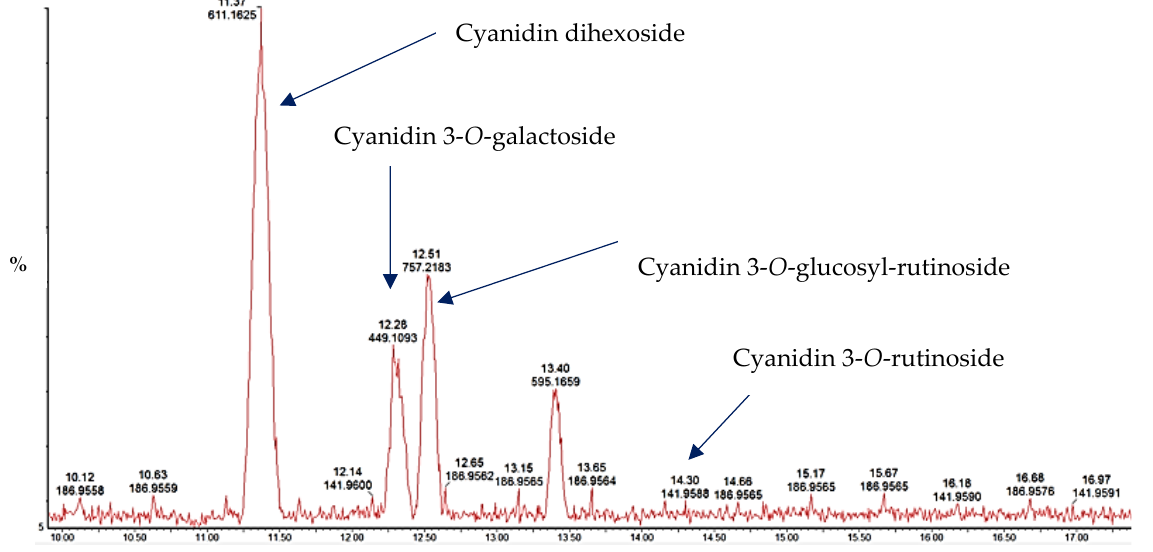
Figure 4. A typical liquid chromatography-mass spectrometry (LC-MS) chromatograph of the major anthocyanin compounds in the oven-dried (60 °C for 18 – 24 h) raspberries and their retention times.